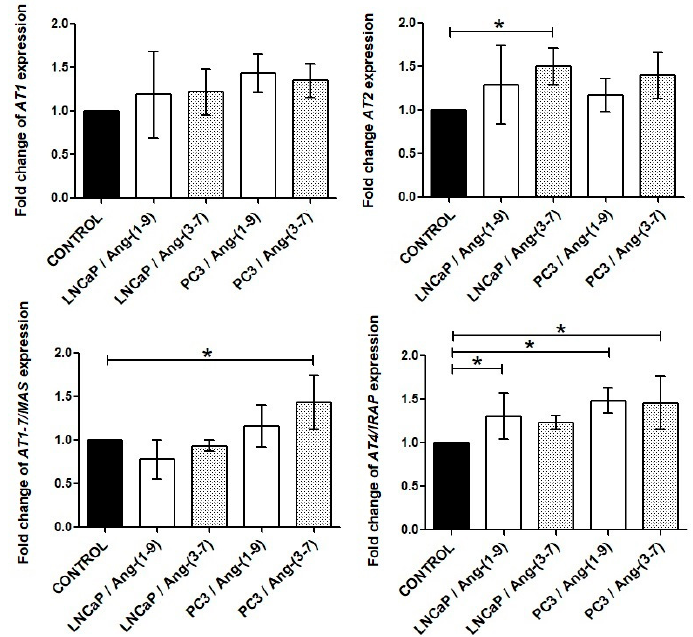
Figure 6. The RT-qPCR results about expression of angiotensin receptor genes in the prostate cancer (mean ± SD; Tukey’s test: * p < lines (LNCaP and PC3) after exposure to Ang-(1-9) or Ang-(3-7) at a concentration of 1 nM for 48 h (mean ± SD; Tukey’s test: * p < 0.05)